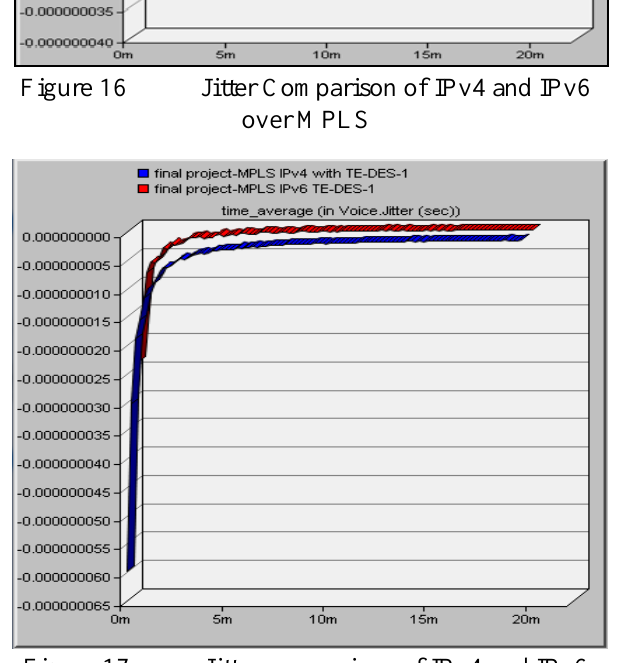
Jitter comparison of IPv4 and IPv6 over